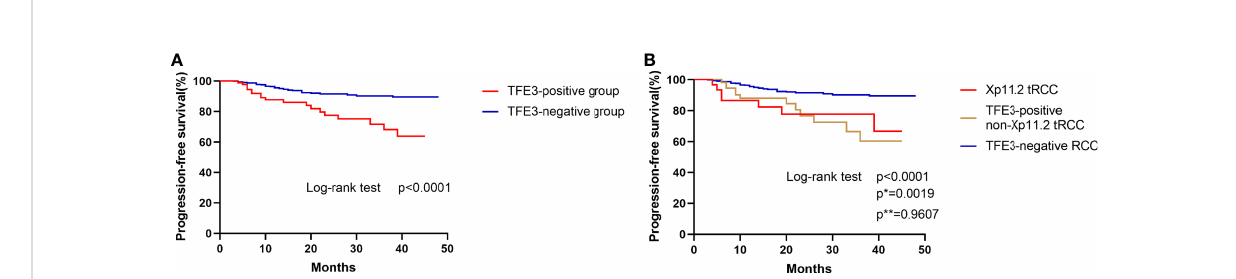
FIGURE 4 Kaplan – Meier curves for progression-free survival. (A) Comparison of progression-free survival between TFE3-positive RCC and TFE3-negative RCC. (B) Comparison of progression-free survival among Xp11.2 translocation renal cell carcinoma, TFE3-positive non- Xp11.2 translocation